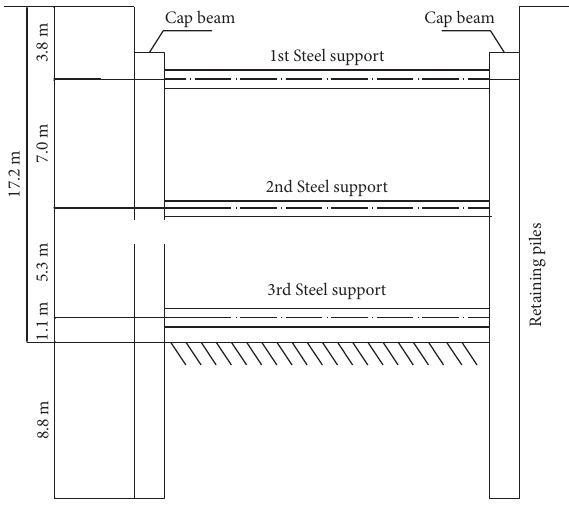
Figure 5: Retaining structures of Station No. 1. Table 2: Feature of the